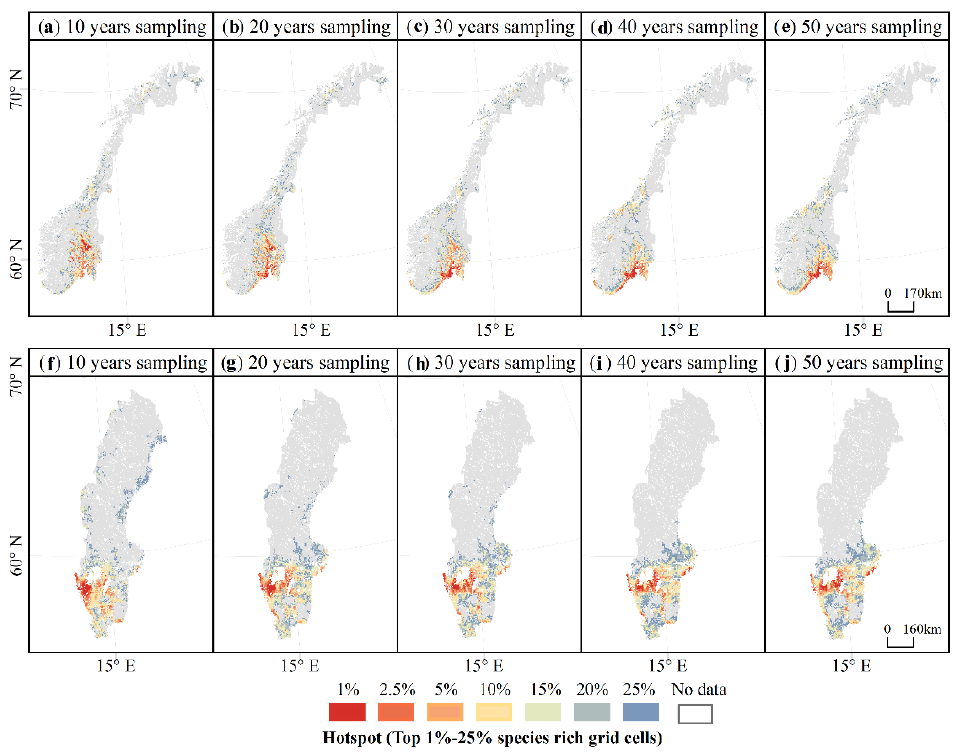
Figure 7. Box plot of the Structural Similarity Index (SSIM) value calculated between the two species richness maps from each of two adjacent sampling periods (i.e., between 20 and 10 years; between 30 and 20 years; between 40 and 30 years; and between 50 and 40 years) for Sweden and Norway. The thick black line denotes the median value, and the points next to the box plots represent the SSIM value of split local maps.